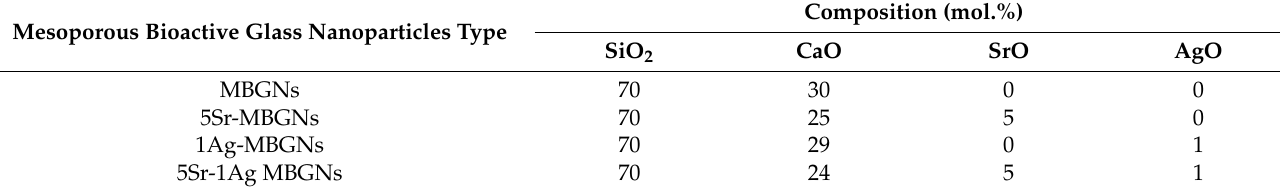
Table 3. Nominal composition of as-synthesized